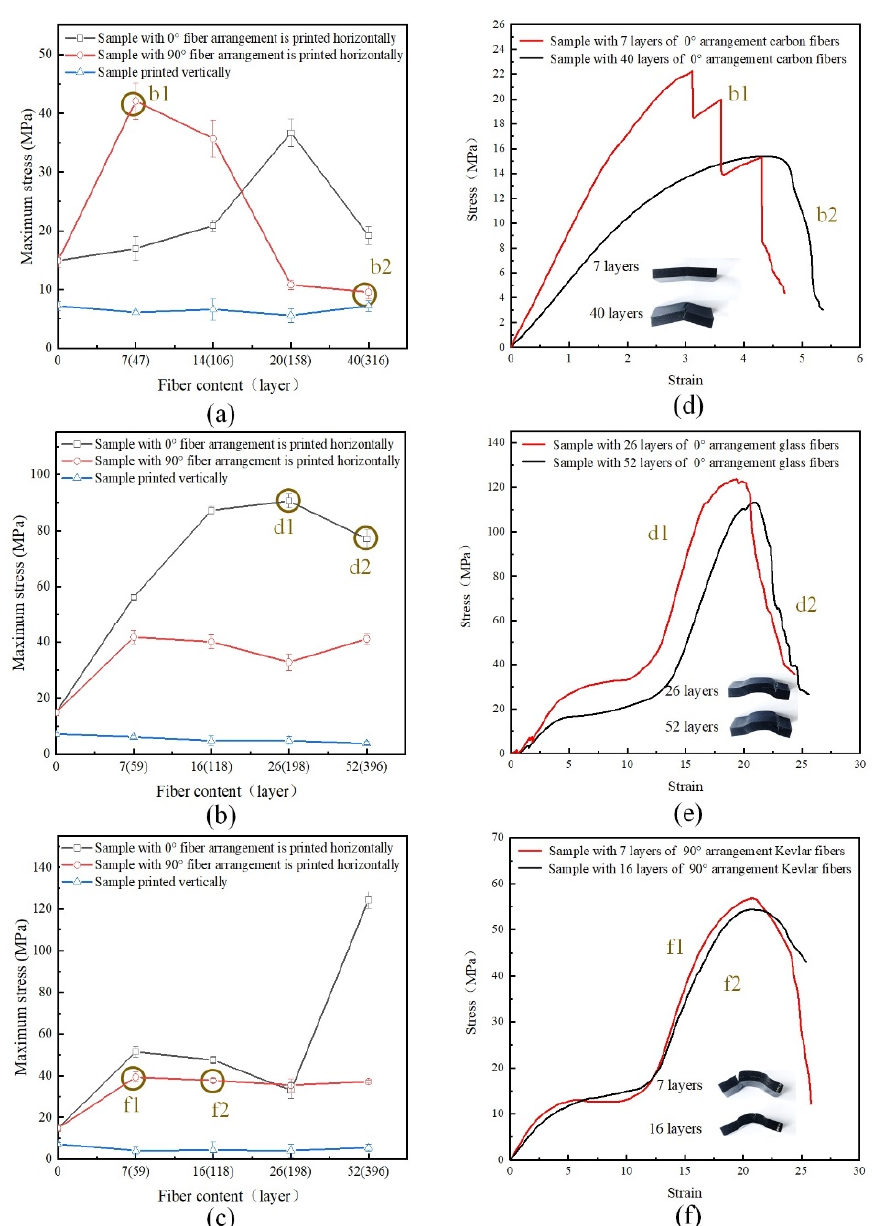
Figure 3. The influence of ( a ) carbon, ( b ) glass, ( c ) Kevlar fibers on the shear behaviors of composites, the stress–strain curve of shear failure of horizontally printed ( d ) carbon fiber, ( e ) glass fiber, and ( f ) Kevlar fiber perpendicular to the short edge.